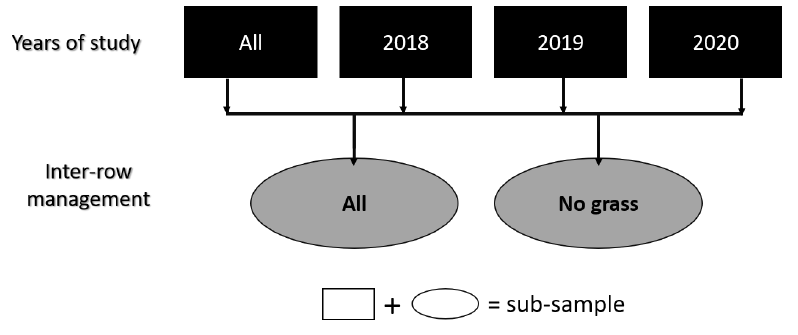
Figure 6. Illustration of the database sub-sample